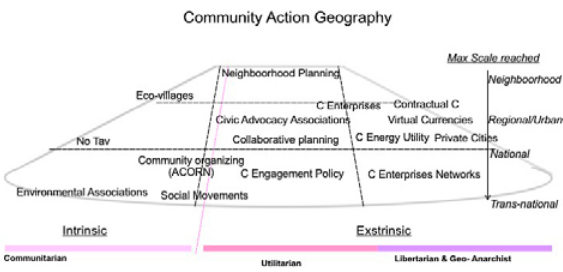
fig. 1. a scheme of community action geography according to value s and maximum-scaled reach for single action typology (elaborated by the